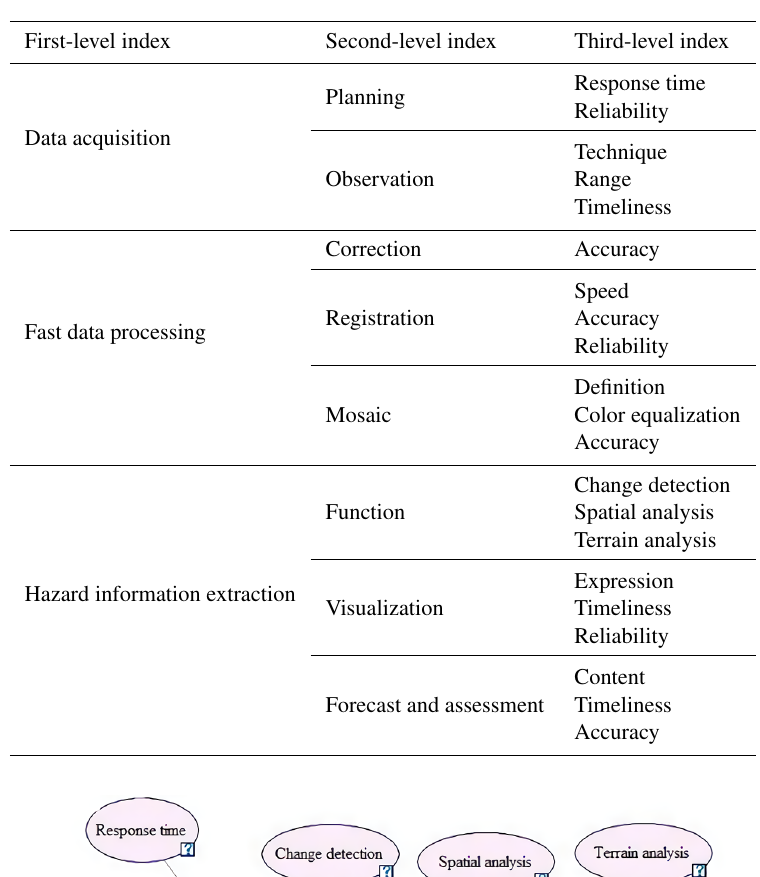
Table 6. Evaluation system for emergency response service capacity.